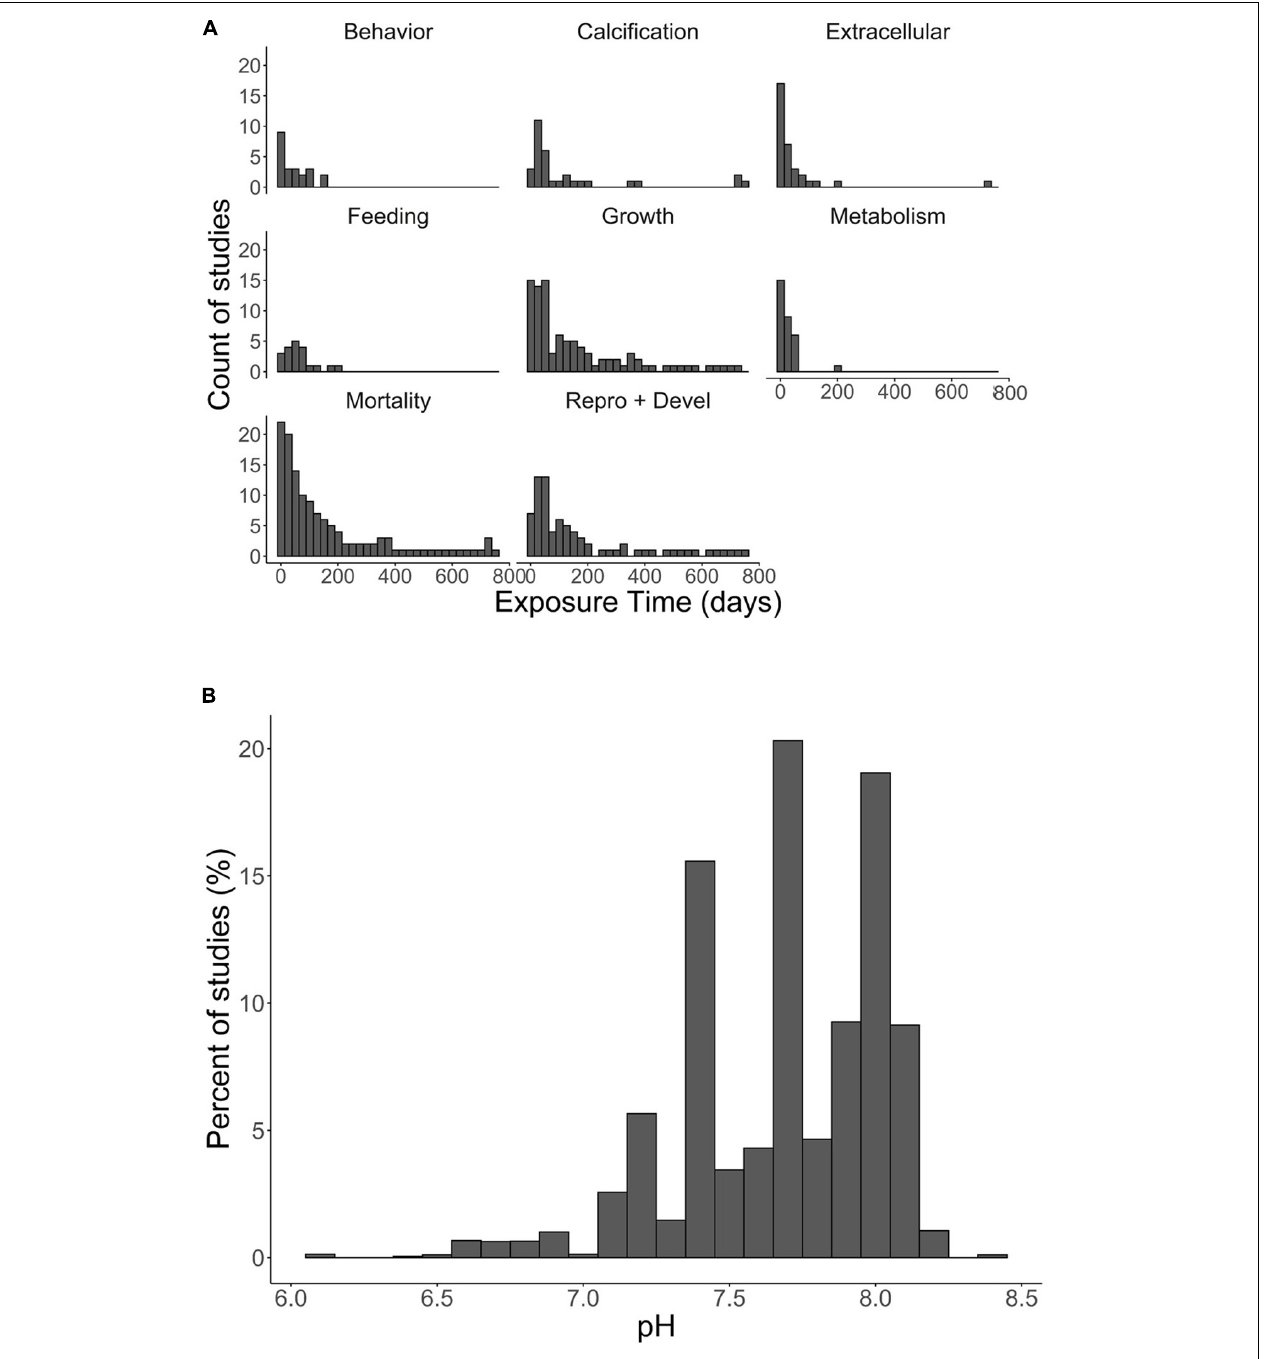
FIGURE 1 | (A) Histogram of percent of studies by mode of effect (graphic heading) and duration of treatment (on X-axis; in days); (B) histogram of distribution of pH treatments by percent of studies.